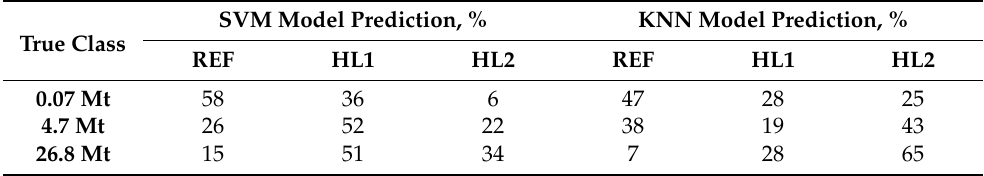
Table 2. The classification results for the SVM and KNN classifiers.